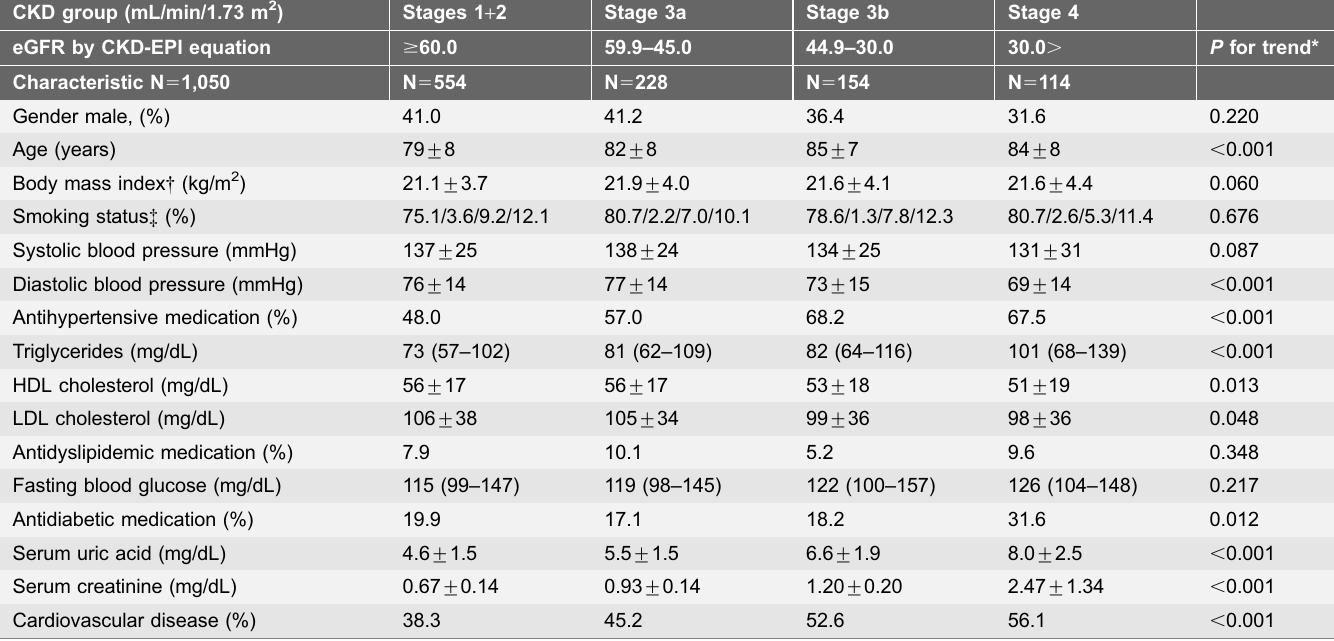
Table 1. Characteristics of various risk factors of the subjects by estimated glomerular filtration ratio. CKD group (mL/min/1.73 m 2